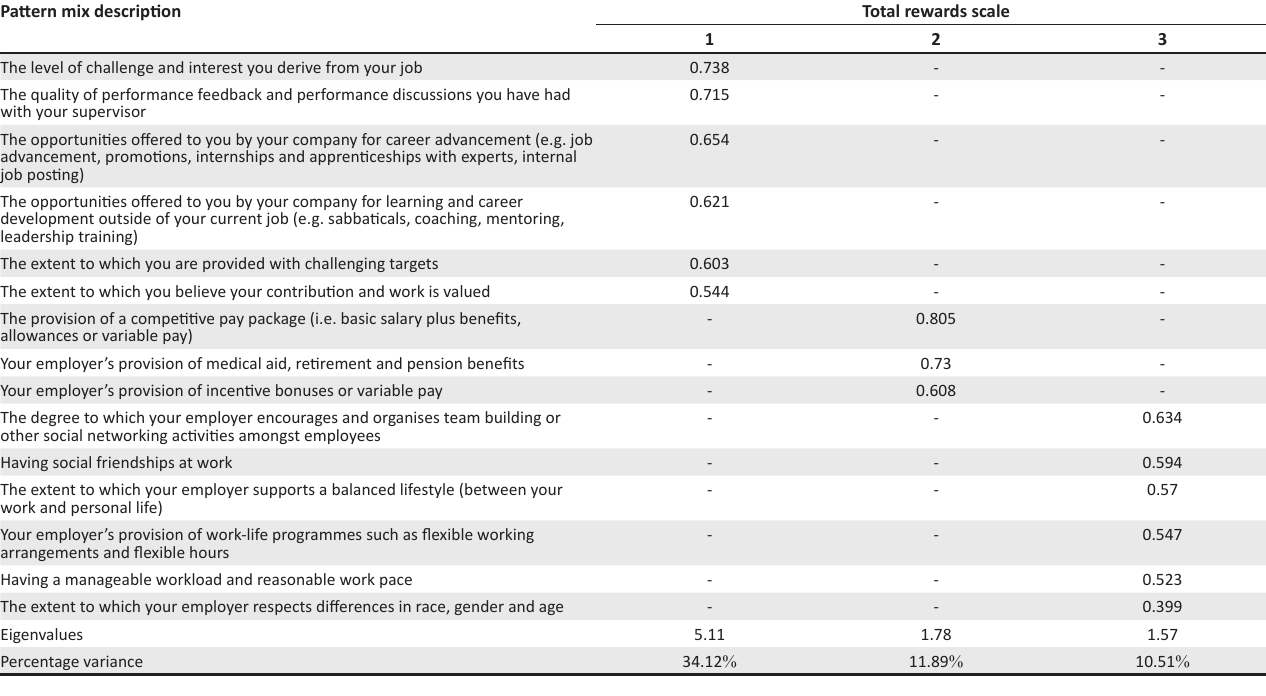
TABLE 8: Factor analysis for total rewards scale.